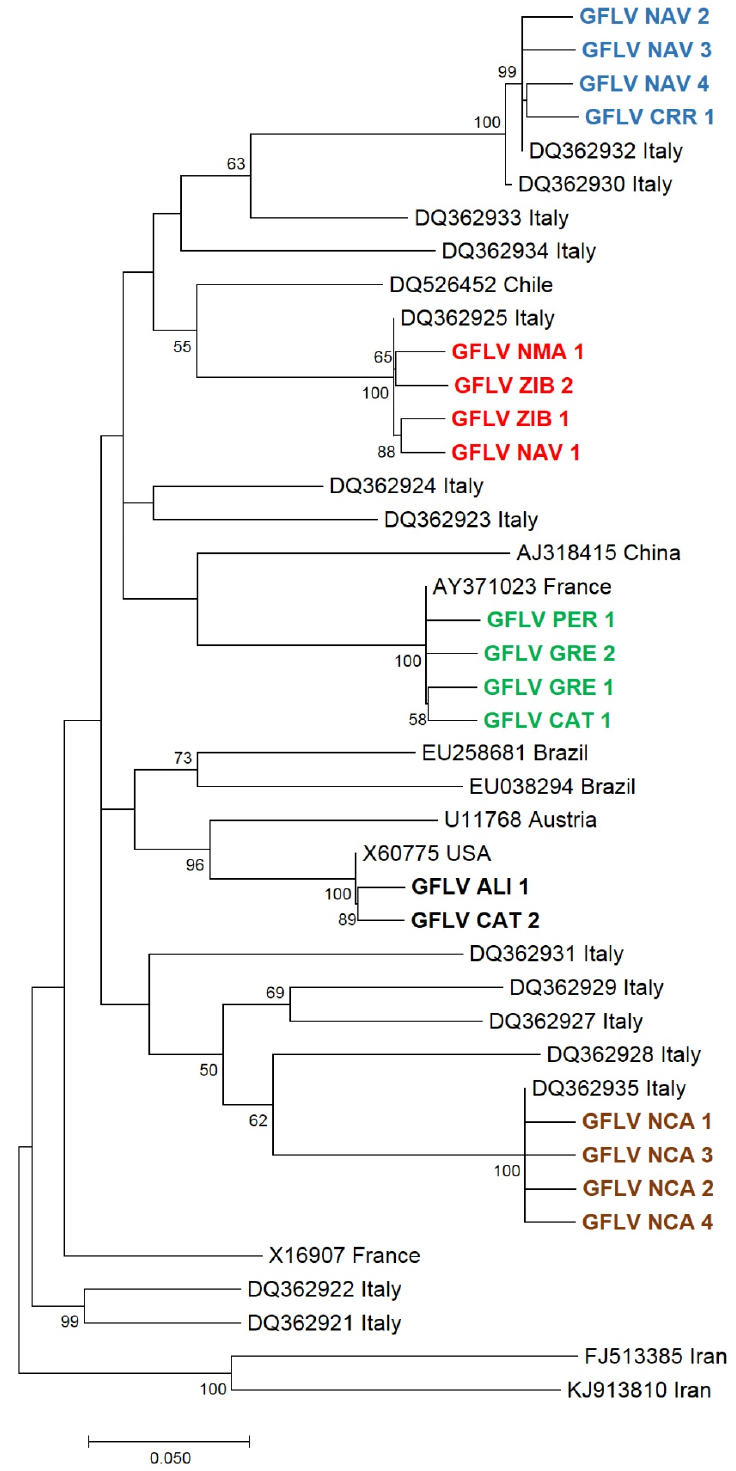
Figure 2. Phylogenetic relationships between coat protein genes of Italian Grapevine fanleaf virus (GFLV) isolates (18 Sicilian sequences obtained in the present work; 14 Italian isolates retrieved from GenBank) and isolates from other countries. The evolutionary history was inferred by using the maximum-likelihood method (ML) based on the Tamura 3-parameter model with bootstraps of 1000 replications, conducted with MEGA X program. Only bootstrap values ≥ 50% are indicated in the nodes. The sequences obtained in the present work are in bold.